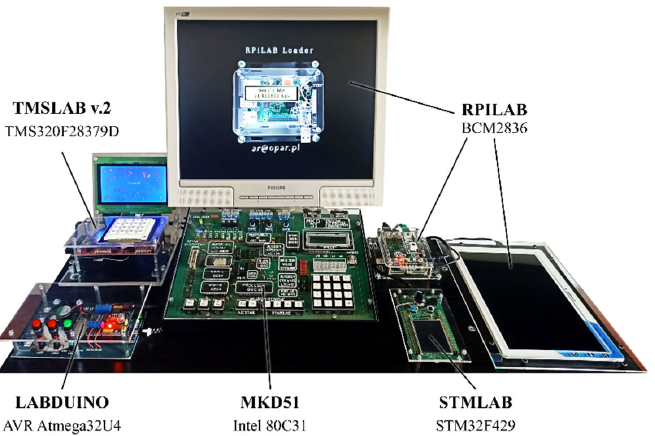
Figure 1. Laboratory stand for embedded microprocessor ‐ system teaching at IAC of LUT [38].